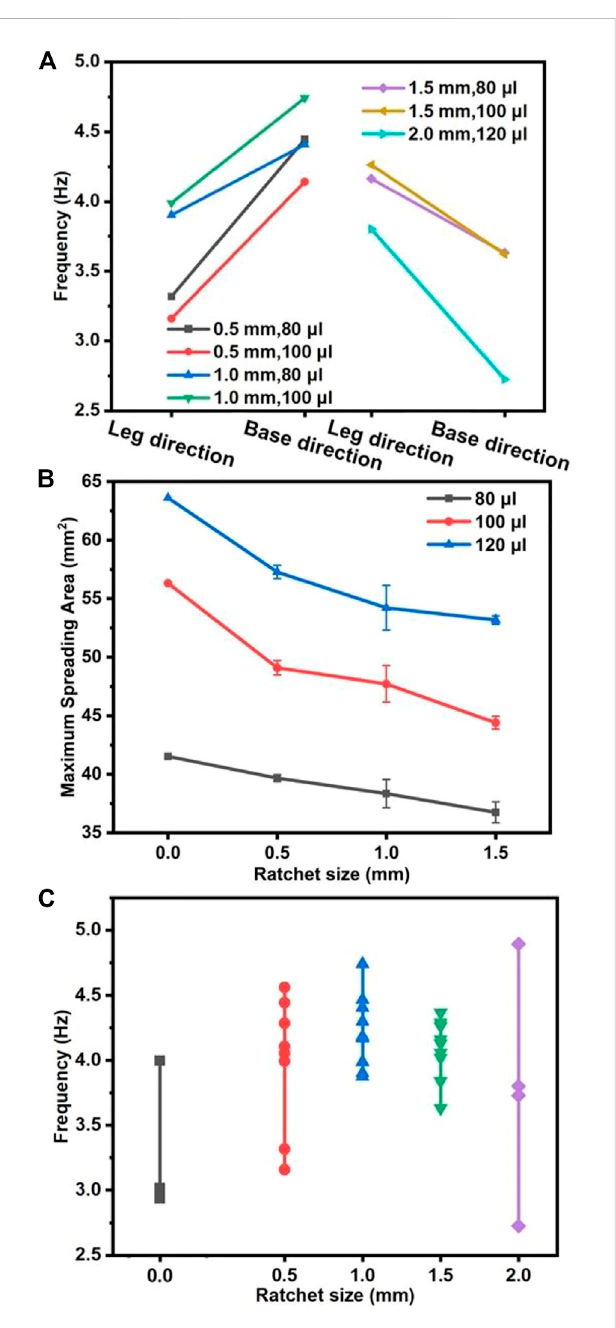
eGaIn drop heart beating performance. (A) Beating frequency of eGaIn drops in the base and leg directions. (B) Spreading area of the eGaIn drop under different ratchet sizes. (C) Beating frequency of the eGaIn drop under different ratchet